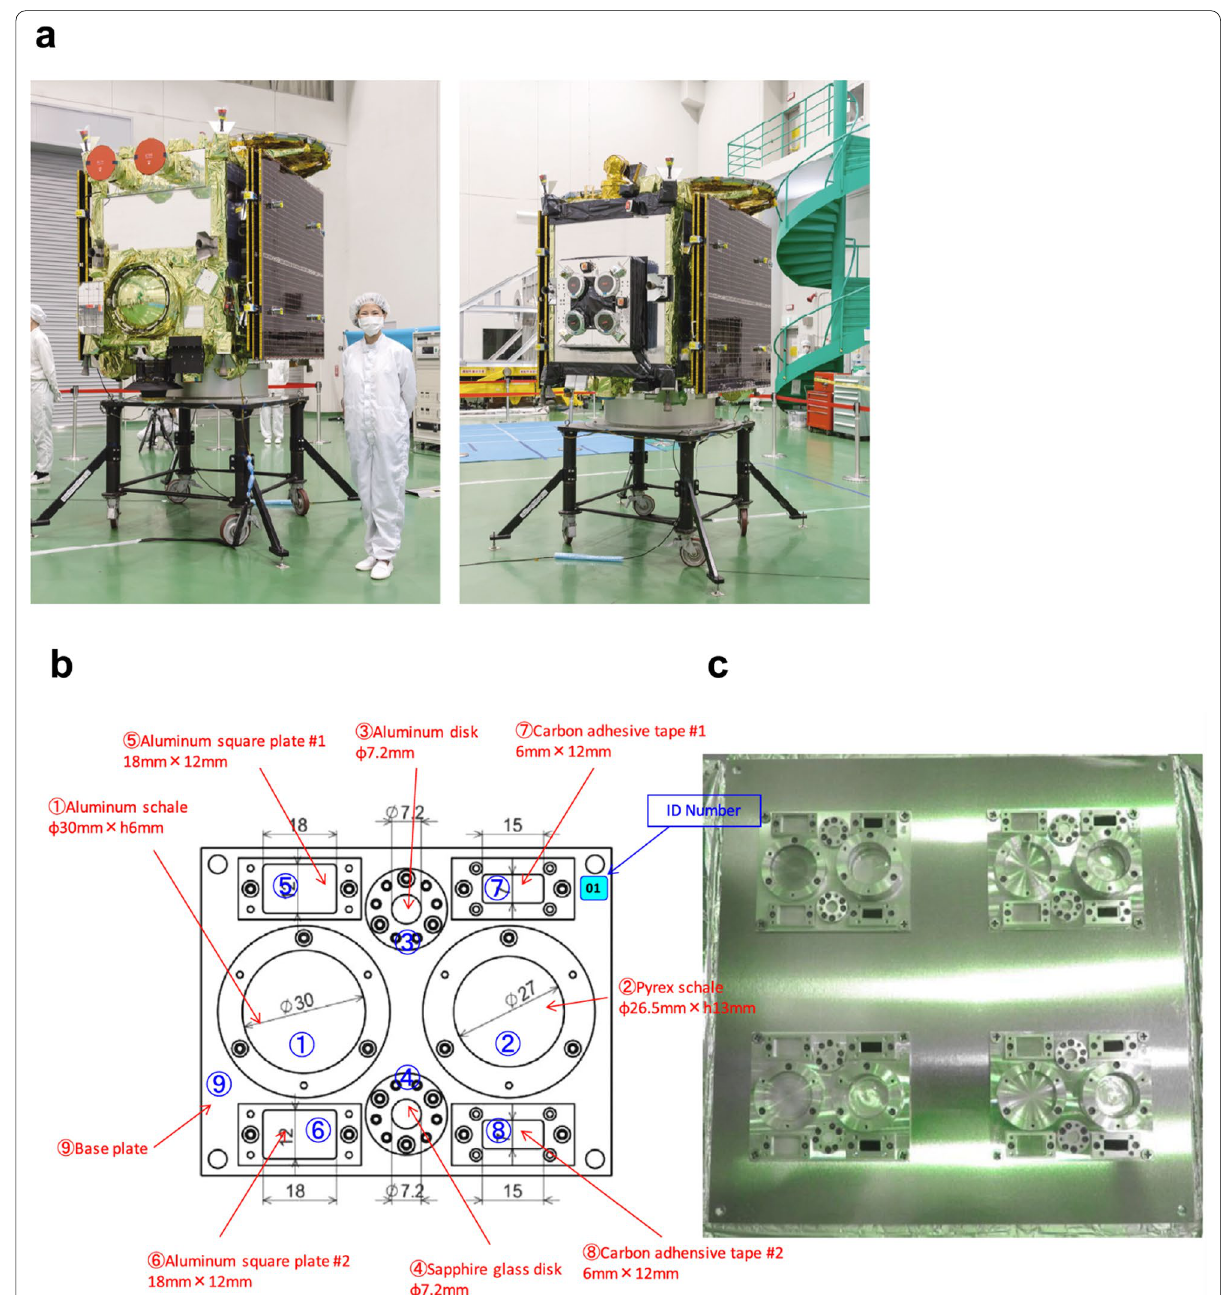
Fig. 1 a Photographs of the Hayabusa2 spacecraft in the clean room at ISAS/JAXA (after Tachibana et al. 2014). Please note that hairdressing, perfumes, skincare, cosmetics, hand sanitizer, lotions, and hair spray are prohibited for any visitors to JAXA’s clean room facilities. b , c Schematic design and appearance of the monitor coupon equipped with an aluminium schale, Pyrex schale, aluminium disk, sapphire glass disk, aluminium square plate (#1, #2), and carbon adhesive tape (#1, #2) for the Hayabusa2 witness coupon (after Sawada et al. 2017). d Environmental assessment procedures for timelines, locations, and operational profiles from static monitoring. Blue and green bars represent the installation time of the coupon and the nitrogen gas purge time into the sampler system, respectively. Abbreviations for locations are defined at the end of the main